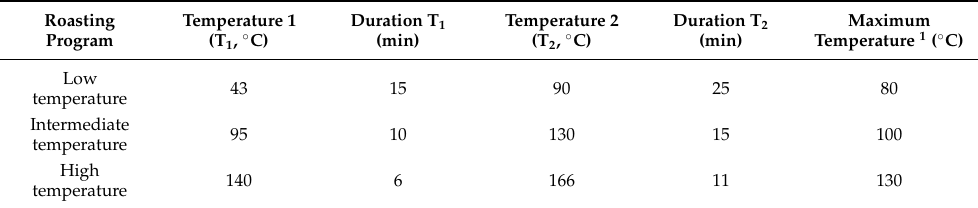
Table 1. Parameters of the 3 different roasting